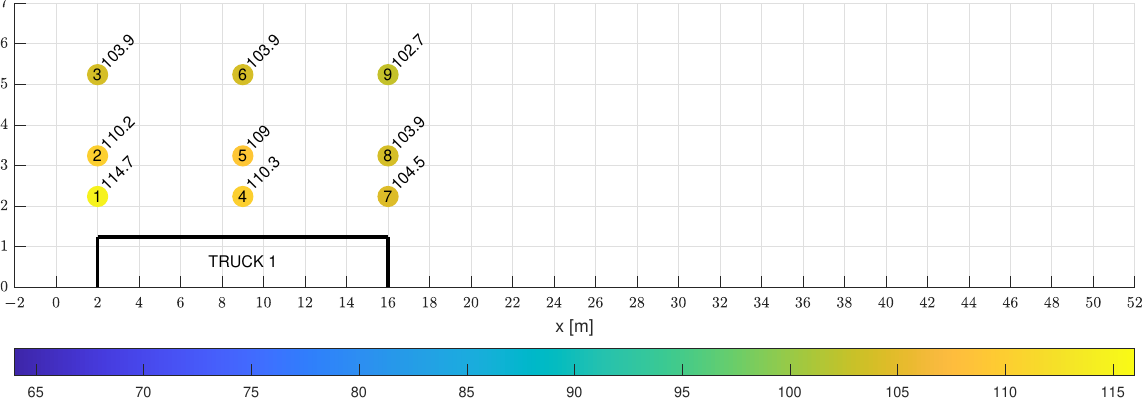
Figure 17. Overall sound pressure level in decibels (dB) on the side of the single truck, measured at receivers for the z-coordinate of 1.7 m. View from the top. For a single truck (Figure 17), the highest values of overall sound pressure levels were observed at points 1, 2, 3, i.e., at the first cross-section, while the lowest values were observed at the third cross-section, i.e., points 7, 8, 9. The maximum value of overall sound pressure levels was 114.7 dB at point 1, i.e., at a distance of 1 m from the vehicle, and the minimum value was 102.7 dB at point 9, at a distance of 4 m from the truck. Additionally, the largest difference in overall sound pressure levels was observed between points 1 and 3 and was 10.8 dB, and the smallest difference was 1.8 dB between points 7 and 9.